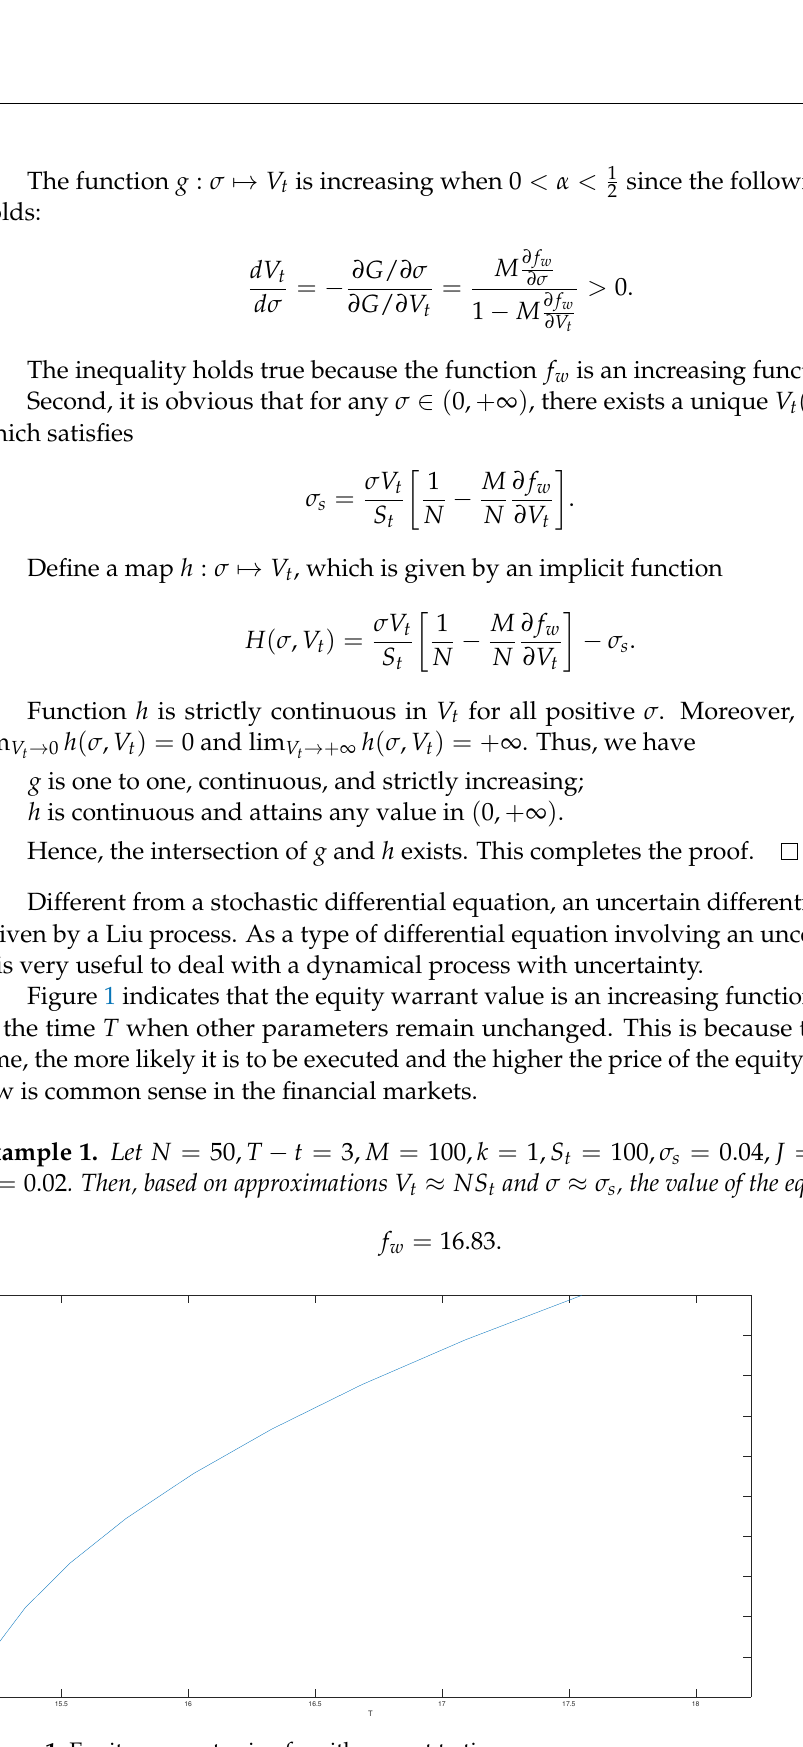
Figure 1. Equity warrant price f w with respect to